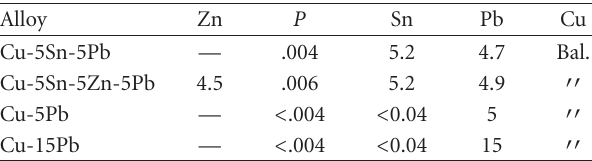
Table 1: Chemical composition of the alloys, wt.% Alloy